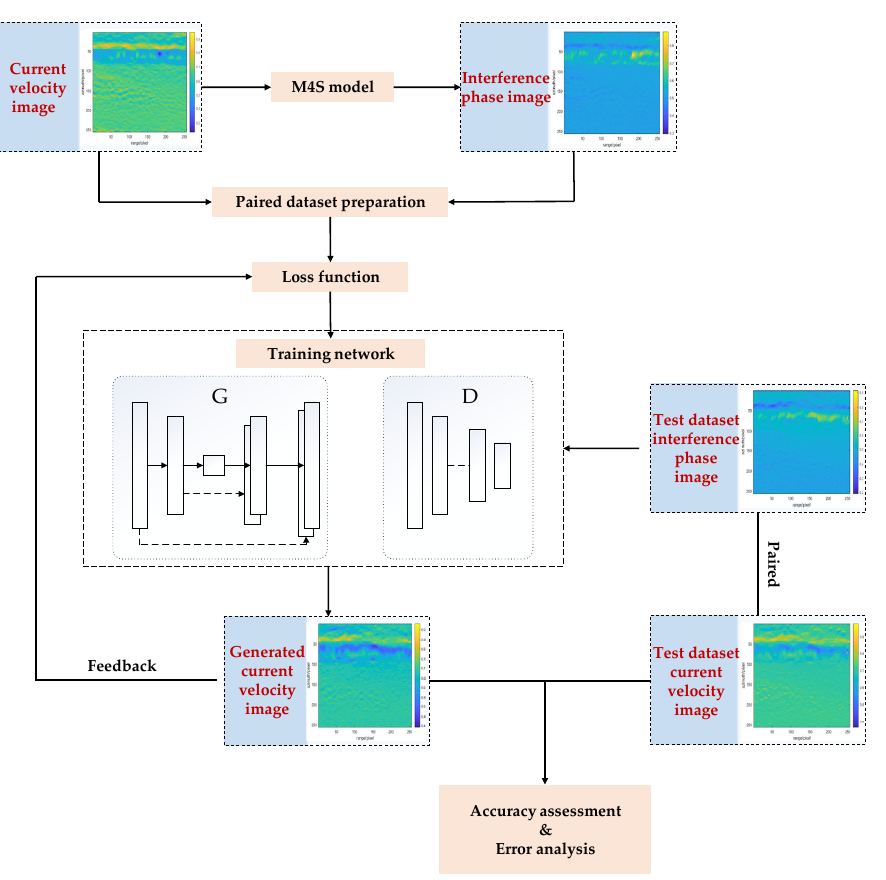
Figure 2. The flow chart of the proposed method. Figure 2. The flowchart of the proposed